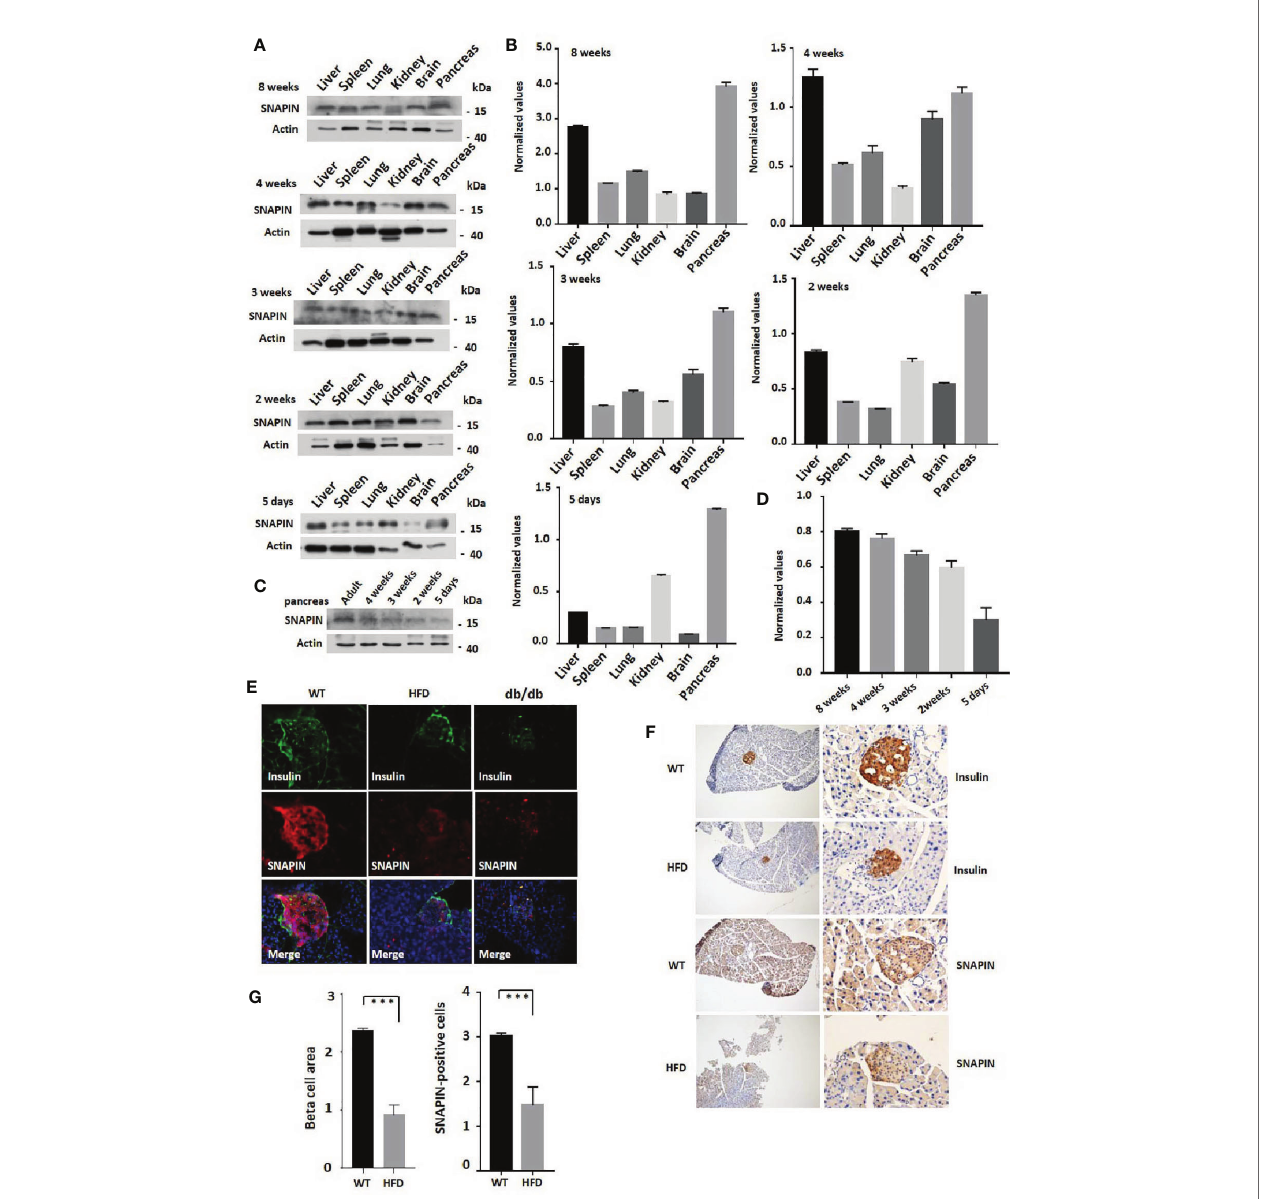
FIGURE 1 | Expression of SNAPIN in mouse tissues. (A) SNAPIN expression was calculated by Western blot. SNAPIN was comparable for 5 days to 8 weeks mouse. (B) Normalized histograms of snapin protein against actin by using imaging software. (C) The expression level of SNAPIN in mouse pancreas also closely increased with the age of mice. (D) Normalized histograms of snapin protein against actin by using imaging software. (E) Representative immuno fl uorescence images of mouse healthy and pre-diabetic pancreases using antibodies against SNAPIN and insulin. The insulin and SNAPIN of HFD mice and db/db mice were signi fi cantly lower than those of wildtype mice. (F) Pancreatic b cell size and SNAPIN expression were calculated from the immunohistochemistry (IHC) sections processed for insulin and SNAPIN by capturing bright fi eld images (Leica CTR 4000 series). The b cell size of high-fat diet (HFD) mice were signi fi cantly smaller than that of wildtype mice, and SNAPIN expression of HFD mice were signi fi cantly lower than that of wildtype mice. Scale bar: 100µm (left) and 50 µm (right). Values are expressed as means ± S.E.M. P<0.001 versus control. (G) Statistics for b cell size and SNAPIN expression. ***P <